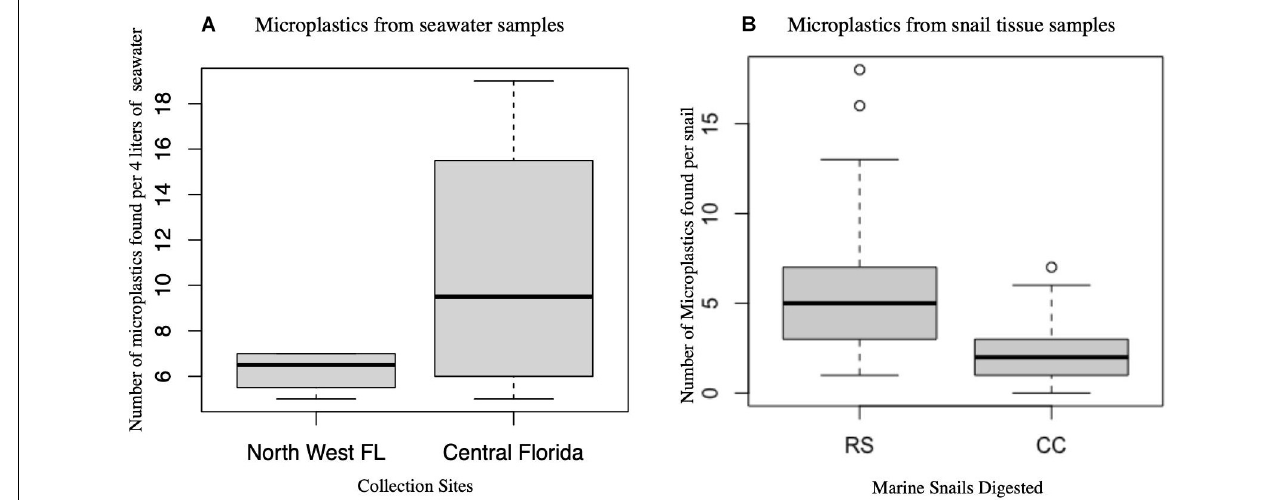
FIGURE 4 | Box plots of microplastics in seawater and snail tissue samples. (A) Microplastics from seawater samples per 4 L collected from two major locations (Northwest Panhandle Florida and Central Florida) are not significantly different. (B) Microplastics from snail tissue samples between the two species of snails (RS, Stramonita haemastoma ; CC, Melongena corona ) are significantly